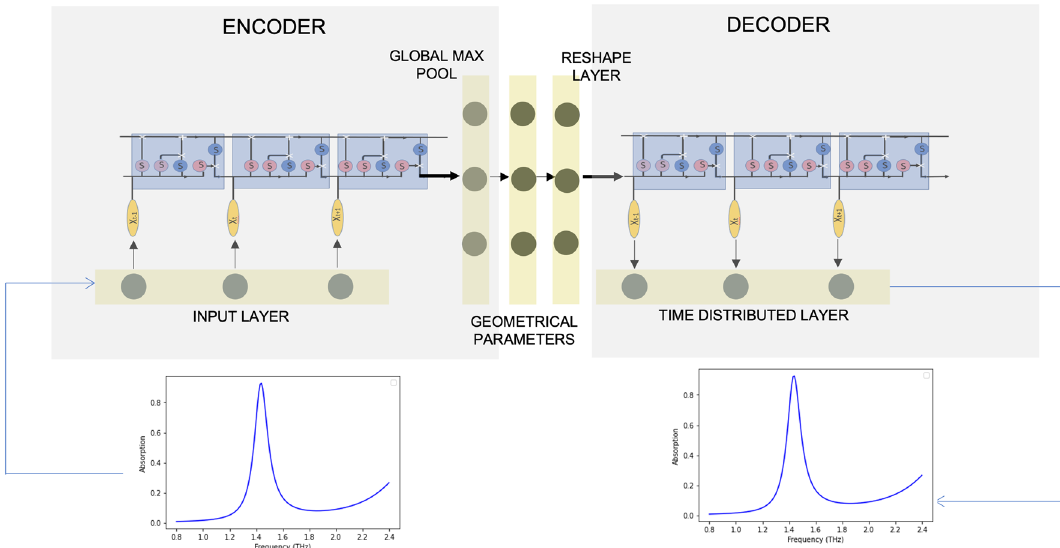
Figure 1. Structure of the deep learning model for deriving structure-property relationships of metamaterials. The architecture represents a tandem network comprising an inverse design network connected to a forward modeling network in an encoder-decoder configuration for predicting the geometrical dimensions by providing the absorption spectra as the input. Geometrical design parameters are obtained from the intermediate layer of the network